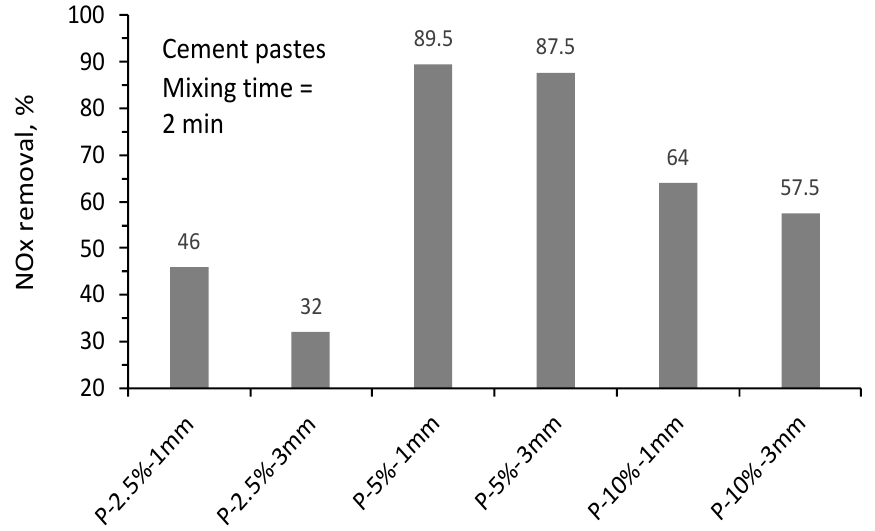
Figure 11. NOx removal (photocatalytic activity) for various TiO 2 concentrations of 2.5%, 5%, and 10% and two coating thickness (i.e., 1 and 3 mm). The NOx removal percentage for various TiO 2 concentrations and two dispersion or 8 min, suggesting that the NOx removal is more affected by the TiO 2 content than by the dispersion time. Thus, two minutes of dispersion are sufficient to secure a maximum photocatalytic activity.